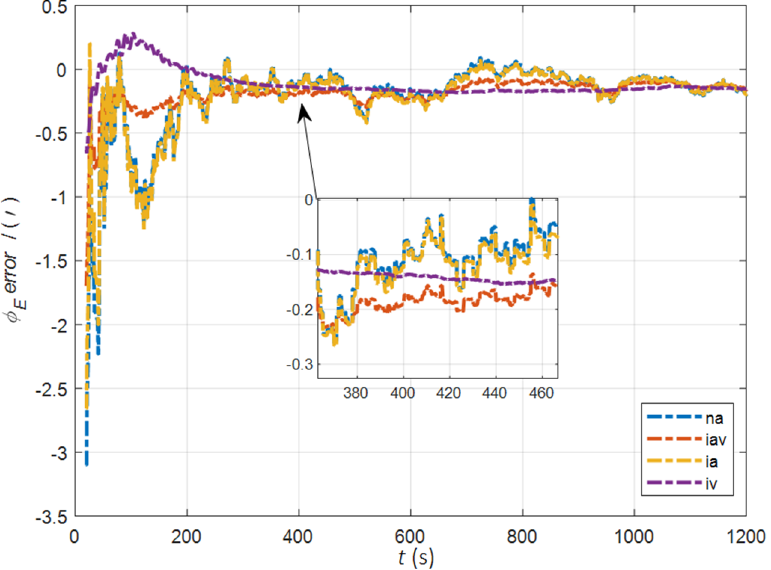
T . ° . Figure 3. The error curves of φ E in the cases of the initial misalignment angles [ 0.2 ◦ 0.2 ◦ 2 ◦ ]